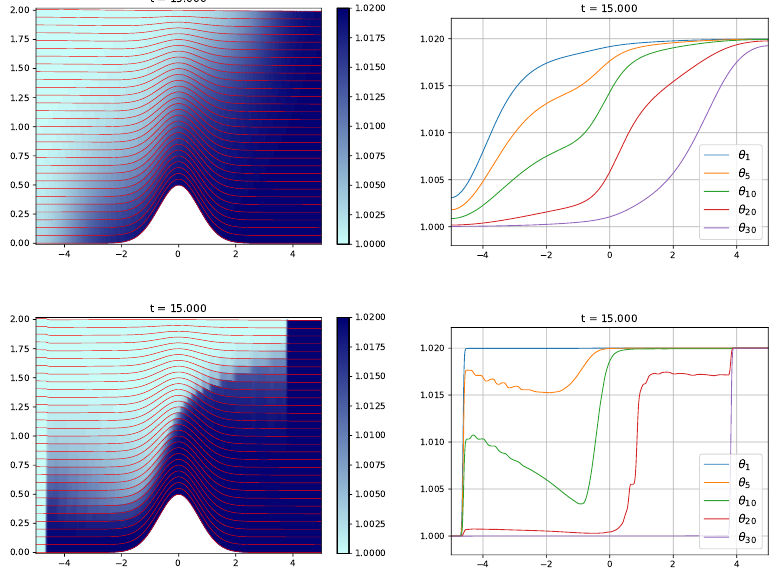
Figure 30. Distribution of the relative density θ . The first row corresponds to the first order scheme and the second row to the second order